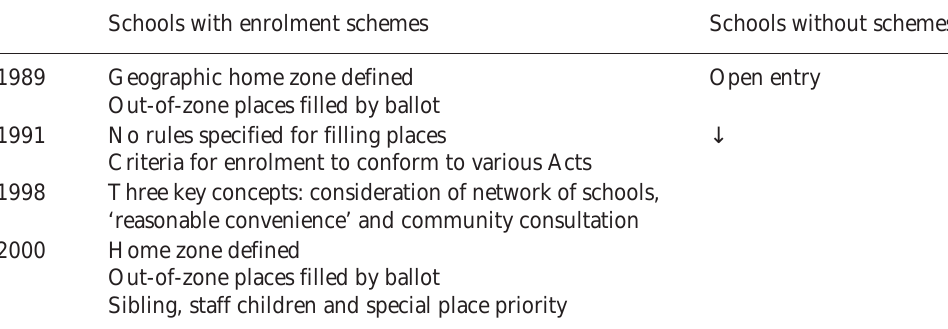
Table 2 Legislation governing enrolment in New Zealand schools Schools with enrolment schemes Schools without